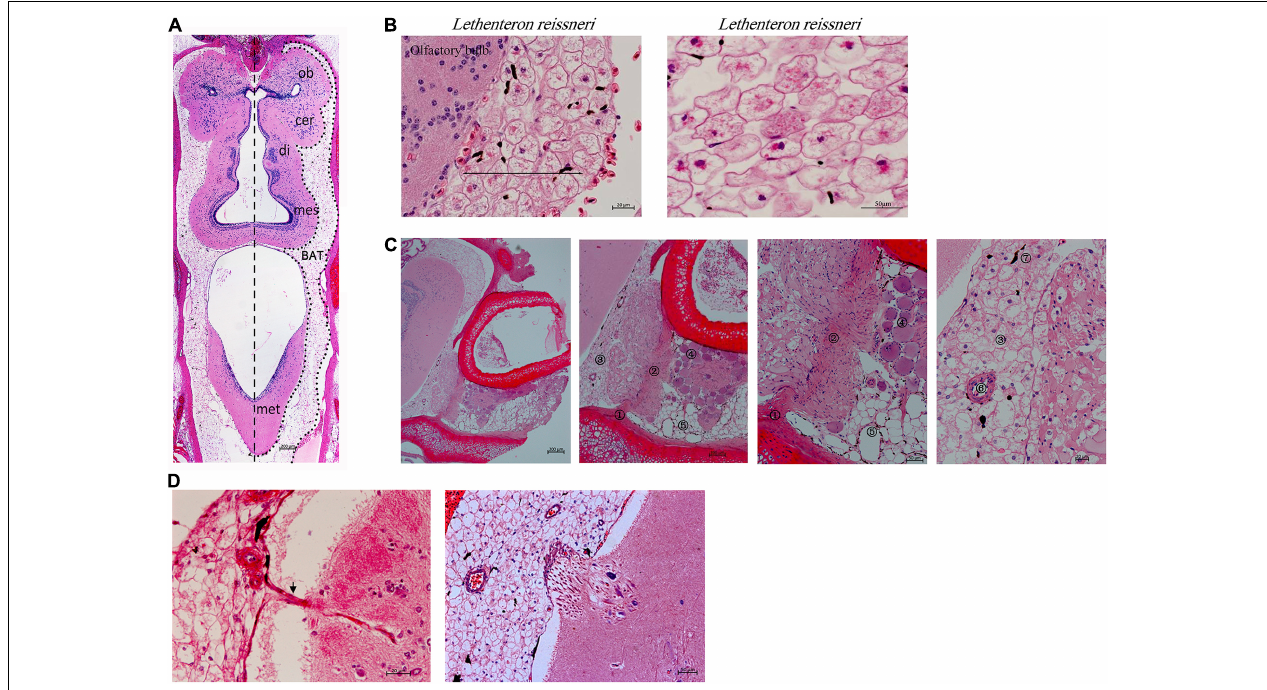
FIGURE 1 | The structure of the lamprey brain and multilocular adipocytes ( Lethenteron reissneri ). (A) Coronal section view of the adult lamprey brain. Scale bars, 200 µ m. (B) The morphology of multilocular adipocytes and the location in the olfactory bulb. di, diencephalon; mes, mesencephalon; met, metencephalon; ob, olfactory bulb; cer, cerebrum. Scale bars, 20 µ m or 50 µ m. (C) Morphological observation of the origin and differentiation of multilocular adipocytes. (cid:172) , myofibroblasts; (cid:173) , myofibroblasts; (cid:174) , multilocular adipocytes; (cid:175) , myotube; (cid:176) , white adipocytes; (cid:177) , blood vessel; (cid:178) , pigment cells. The images on the right are partial magnifications of the image on the left. (D) The black arrow shows that multilocular adipocytes can extend into brain tissue (left pane). The interaction of multilocular adipocytes with the brain (right